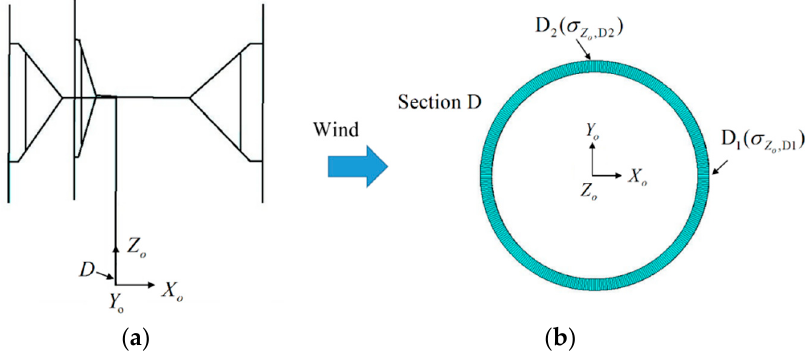
Figure 13. Fatigue-critical points of the tower: ( a ) Position of Section D; ( b ) Critical points in Section D.